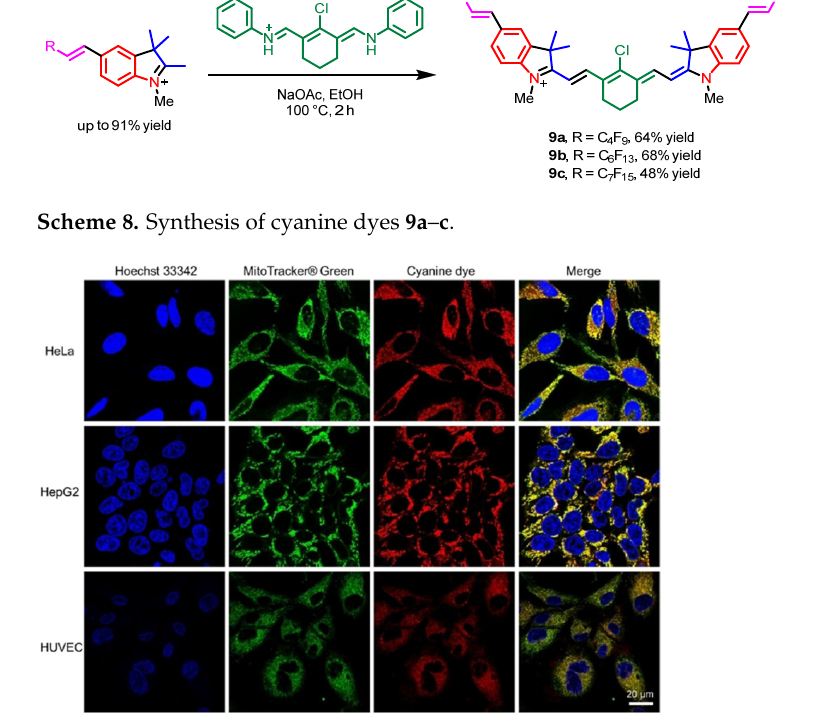
Figure 9. Confocal fluorescence images of various cell lines (HeLa, HepG2, and HUVEC cells) stained with cyanine dye 9b , the mitochondria indicator MitoTracker Green, and the nucleus indicator Hoechst 33,342. Adapted from [31].